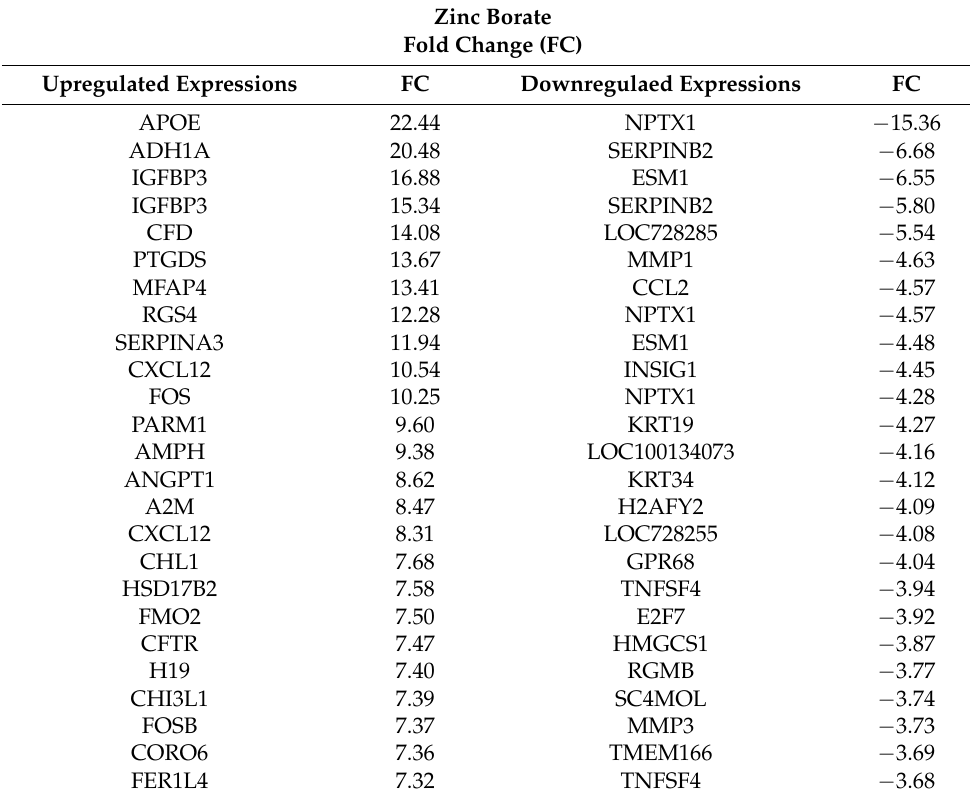
Table 2. Gene expression changes with respect to zinc borate (Zn 3 BO 6 ) NPs application.